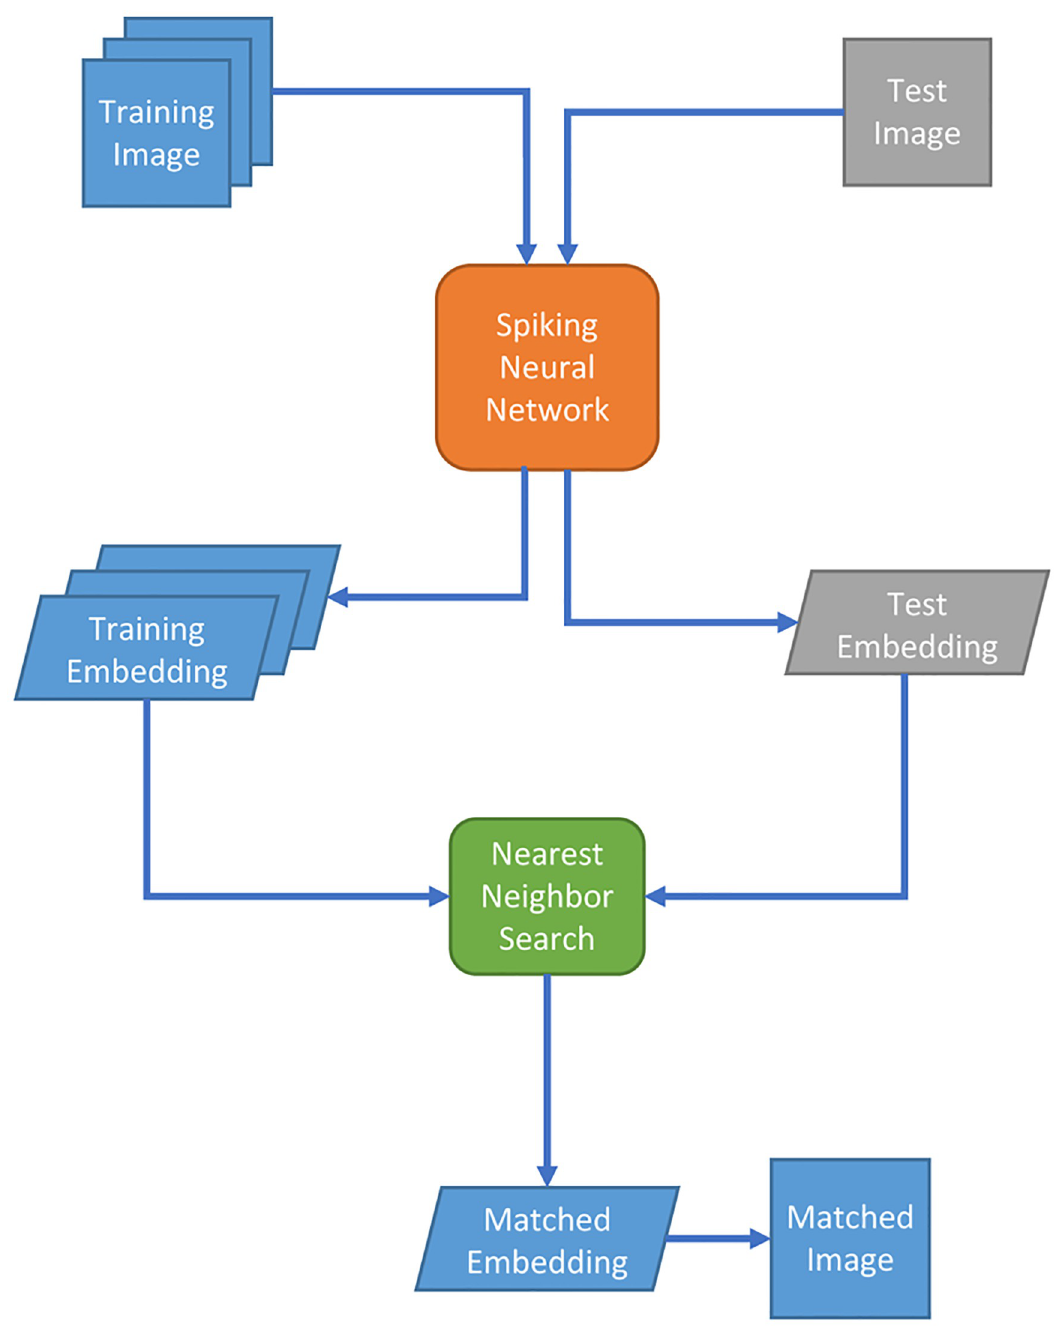
Fig 1. Pipeline of image retrieval by spiking neural